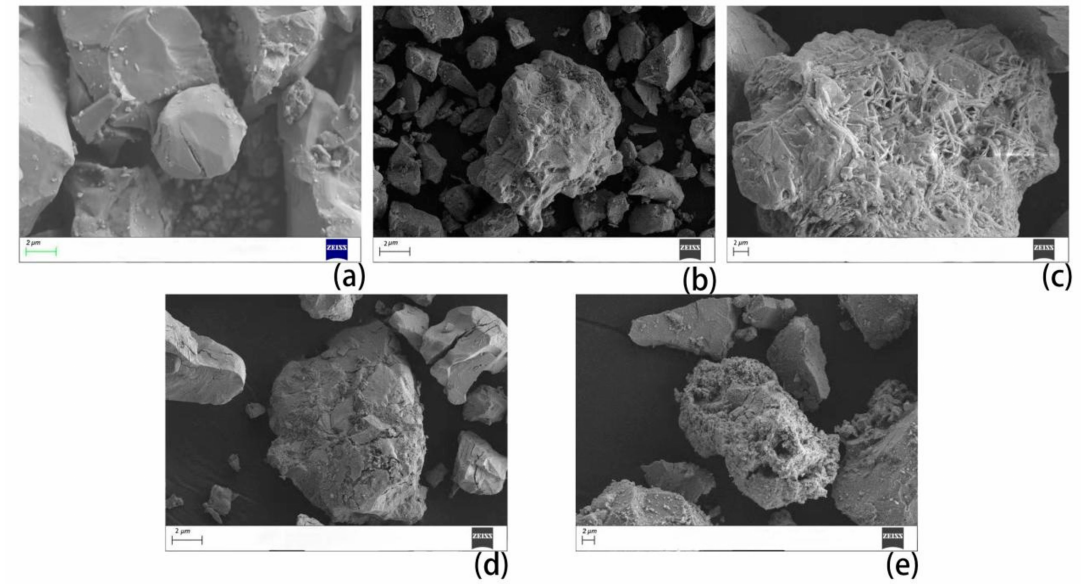
Figure 1. SEM characterization of rare earth concentrates subjected to di ff erent treatments. ( a ) Sample 1, ( b ) Sample 2, ( c ) Sample 3, ( d ) Sample 4, ( e ) Sample